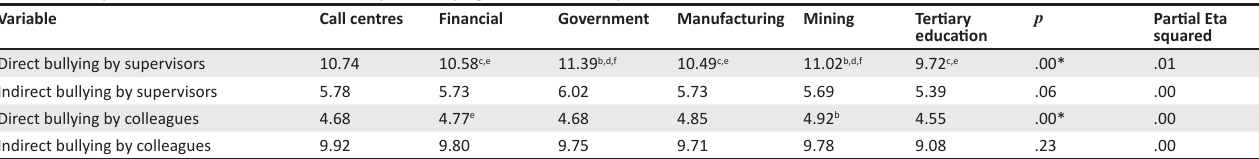
TABLE 9: Analysis of variance – differences in workplace bullying based on industry.